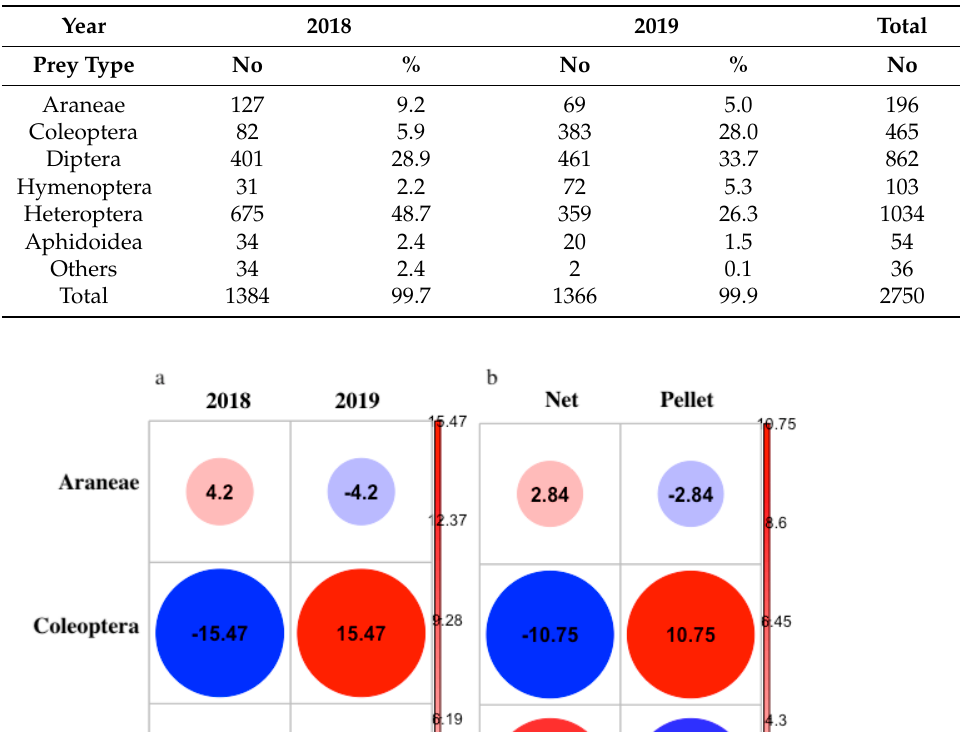
Table 3. Number of arthropods sampled within Mirandola reedbed in 2018 and 2019.